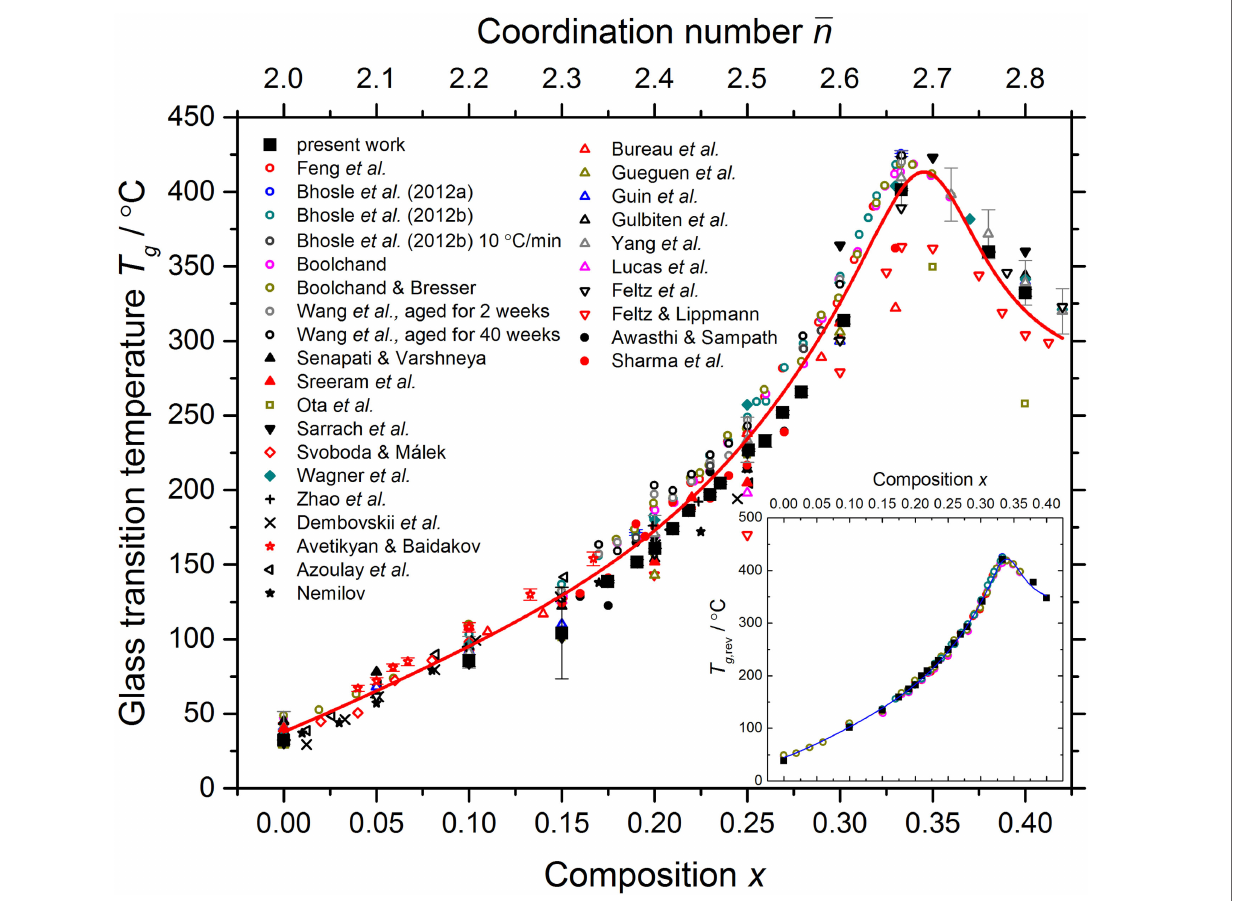
FIGURE 4 | The dependence of the glass transition temperature T g for the Ge x Se 1 (cid:0) x system, as measured using a variety of methods, on the composition x and mean coordination number ¯ n = 2 ( 1 + x ) . The results obtained from the total heat flow in the present work are compared to the results obtained by Avetikyan and Baidakov (1972), Awasthi and Sampath (2002), Azoulay et al. (1975), Bhosle et al. (2012a,b), Boolchand (2000), Boolchand and Bresser (2000), Bureau et al. (2003), Dembovskii et al. (1965), Feltz and Lippmann (1973), Feltz et al. (1983), Feng et al. (1997), Gueguen et al. (2011), Guin et al. (2002a), Gulbiten et al. (2013), Lucas et al. (2003), Nemilov (1964), Ota et al. (1978), Sarrach et al. (1976), Senapati and Varshneya (1996), Sharma et al. (2005), Sreeram et al. (1991a), Svoboda and Málek (2015), Wagner et al. (1997), Wang et al. (2005), Yang et al. (2013), and Zhao et al. (2013). The inset shows solely the results for T g,rev as obtained in the present work and in the work of Boolchand and coworkers (Feng et al., 1997; Boolchand, 2000; Boolchand and Bresser, 2000; Wang et al., 2005; Bhosle et al., 2012a,b)—see Section 3.1 for details. The solid (red) curve in the main panel gives a least-squares fit of the measured data sets to a fourth-order polynomial at x . 0.32 and to a Lorentzian function at larger x values. The solid (blue) curve in the inset gives a similar least-squares fit to the measured T g,rev